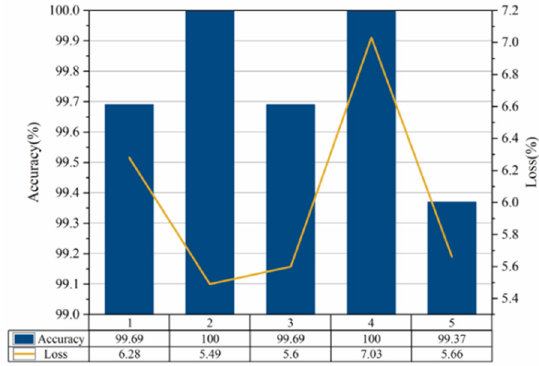
Figure 10. Accuracy and loss rates for multiple tests.